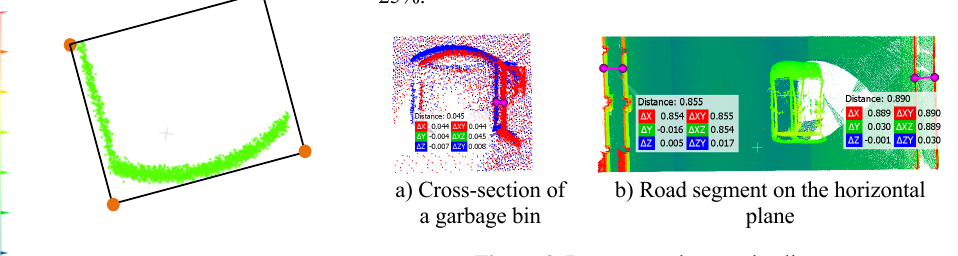
Figure 8 . Data errors due to mis-alignment